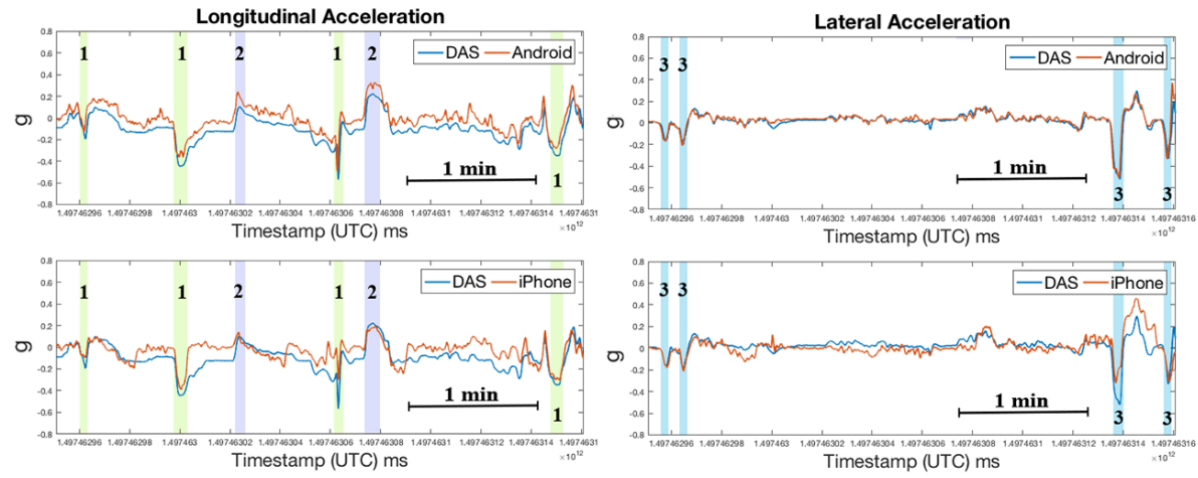
Figure 12. Acceleration measurements acquired during first 3.4 minutes of street driving in Christiansburg, VA (black box in Figure 11): brake (1), acceleration (2), and right turn (3). DAS: data acquisition system; UTC: Coordinated Universal